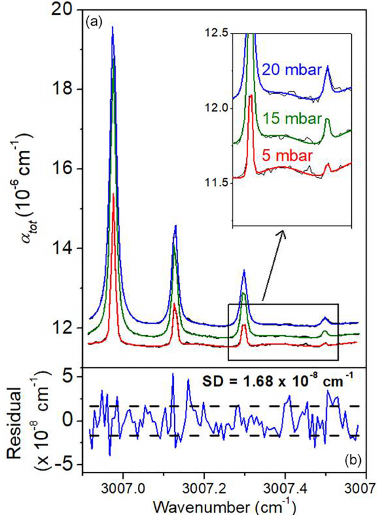
Figure 1. (a) Total absorption coefficient measured by OFCEAS when the optical cavity is filled by water at three different pressures for a temperature of 50 ◦ C. Black lines are experimental data, while the coloured lines correspond to spectral fits, as described in the text. (b) Residuals of the fit for the spectrum at